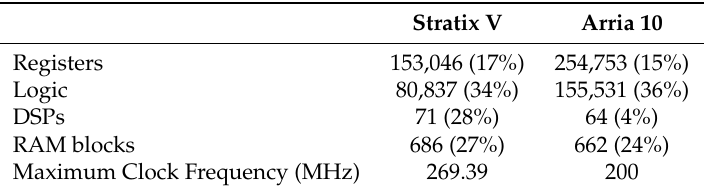
Table 2. Hardware resources for Jacobi